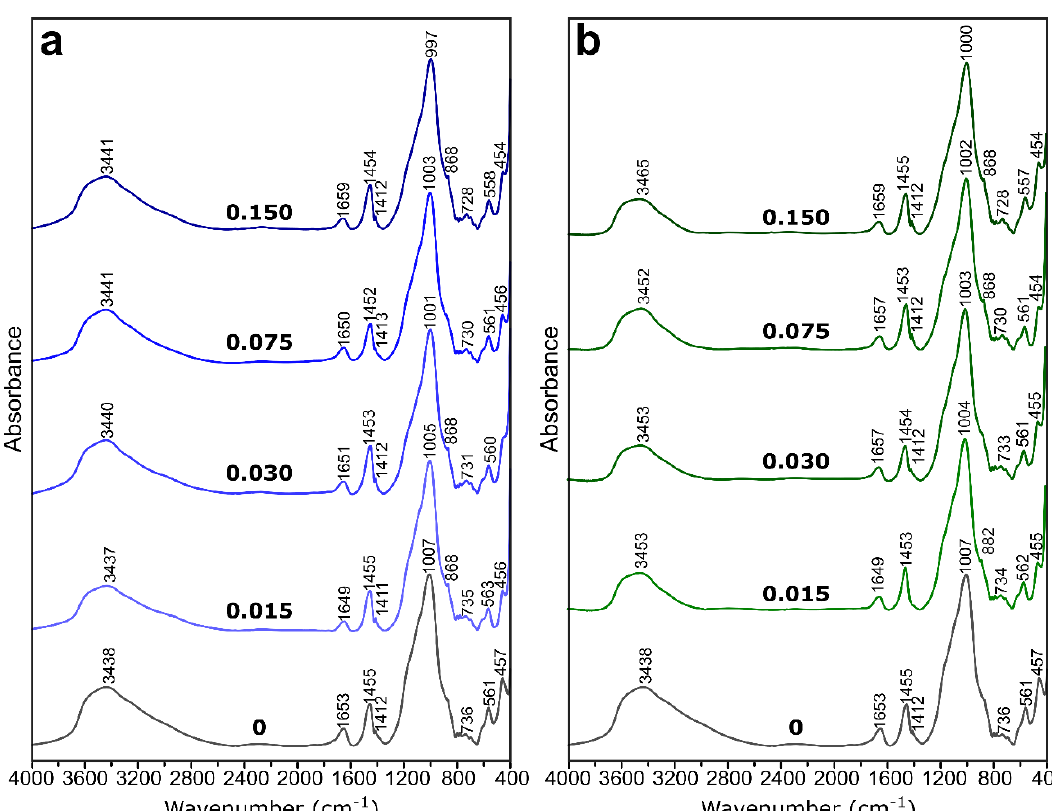
Figure 5. The FT-IR spectra of the geopolymers with borax ( a ) and boric acid ( b ). 0—reference sample without boron.